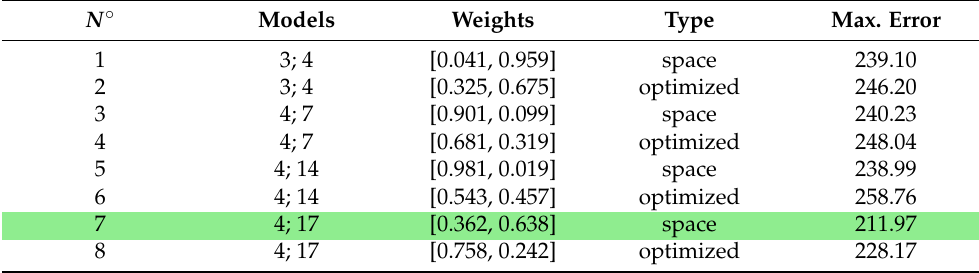
Table 15. Ensemble models tested using two single models and the maximum error obtained. Green row is the ensemble model selected.